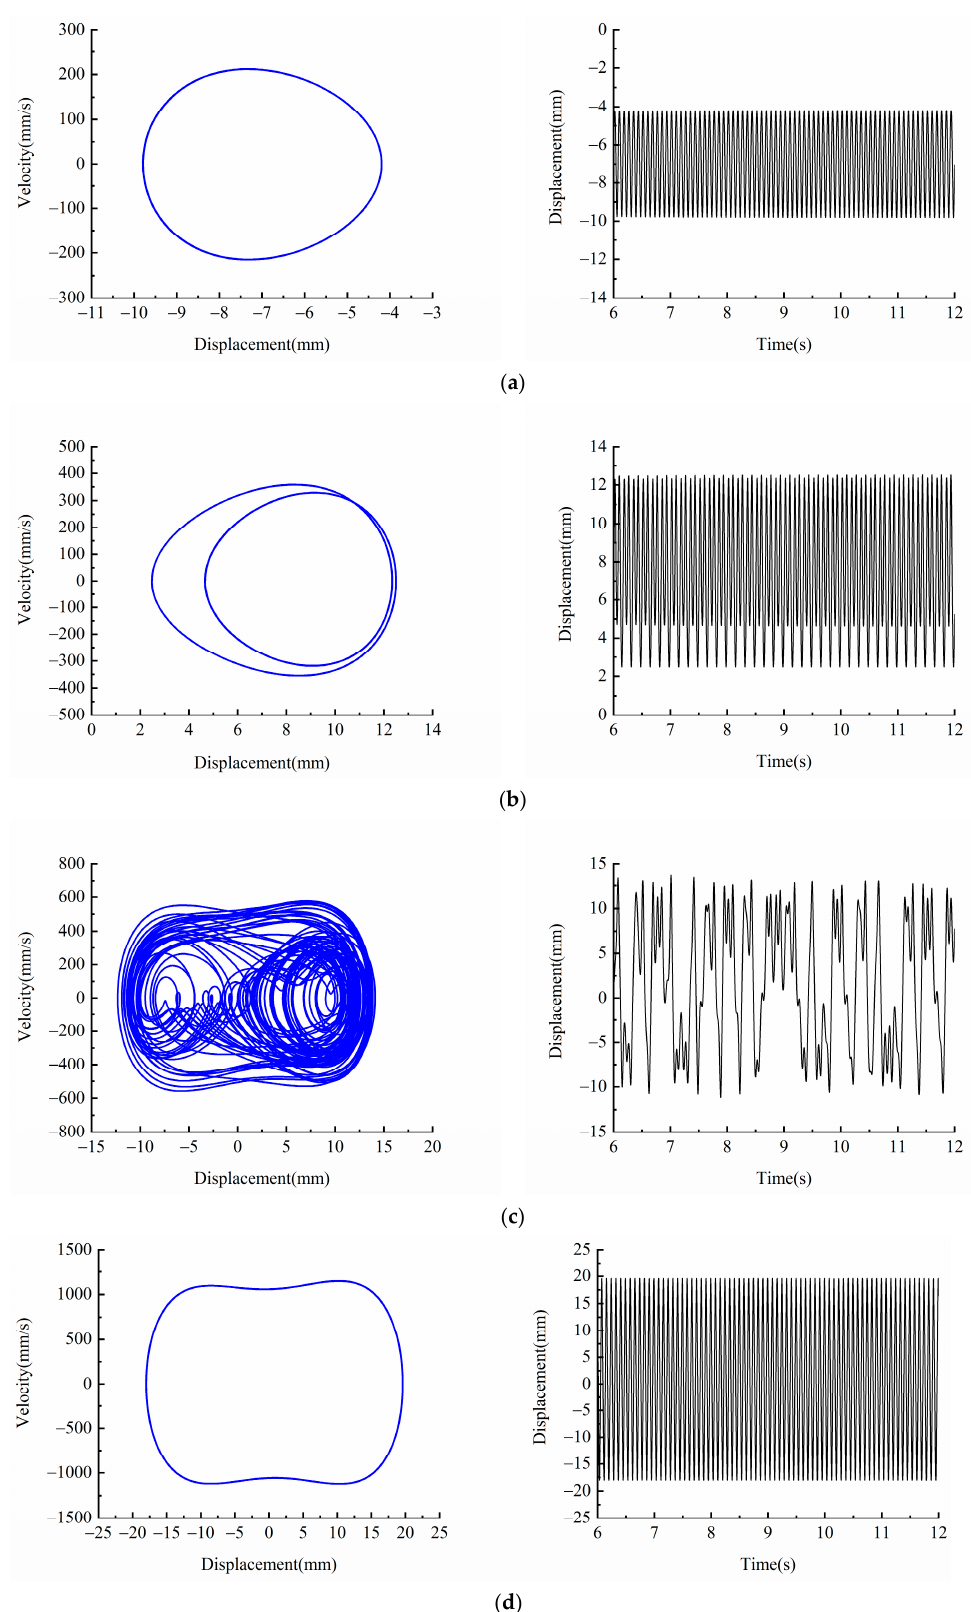
Figure 6. Phase portrait and time-displacement diagram of different excitation amplitudes 𝐴 : ( a ) 𝐴 = 5 m/s (cid:2870) ; ( b ) 𝐴 = 9 m/s (cid:2870) ; ( c ) 𝐴 = 12 m/s (cid:2870) ; ( d ) 𝐴 = 18 m/s (cid:2870) . ( a ) A = 5 m/s 2 ; ( b ) A = 9 m/s 2 ; ( c ) A = 12 m/s 2 ; ( d ) A = 18 m/s 2